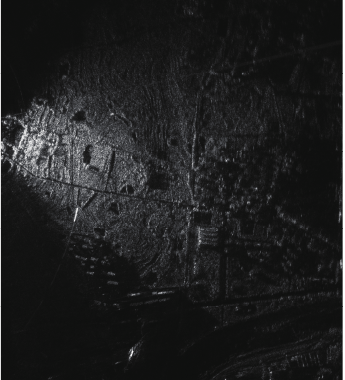
Figure 13. Imaging result of the equivalent experiment by ‘non-stop-and-go’ RMOSE method.